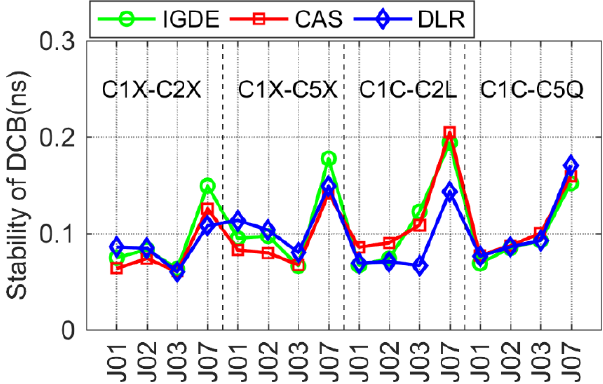
Figure 16. Stability of the QZSS DCB obtained by IGDE, CAS, and DLR.